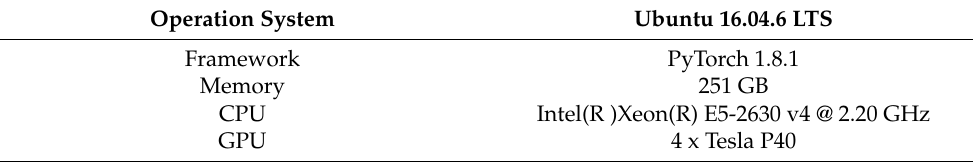
Table 2. Experimental